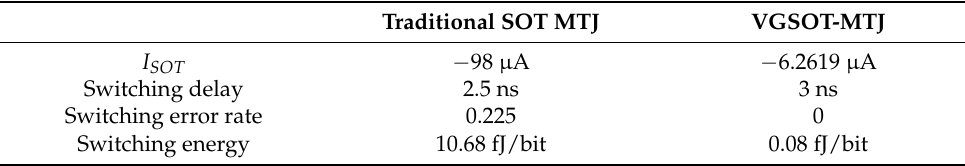
Table 3. Performance comparison: SOT vs. VGSOT [20].